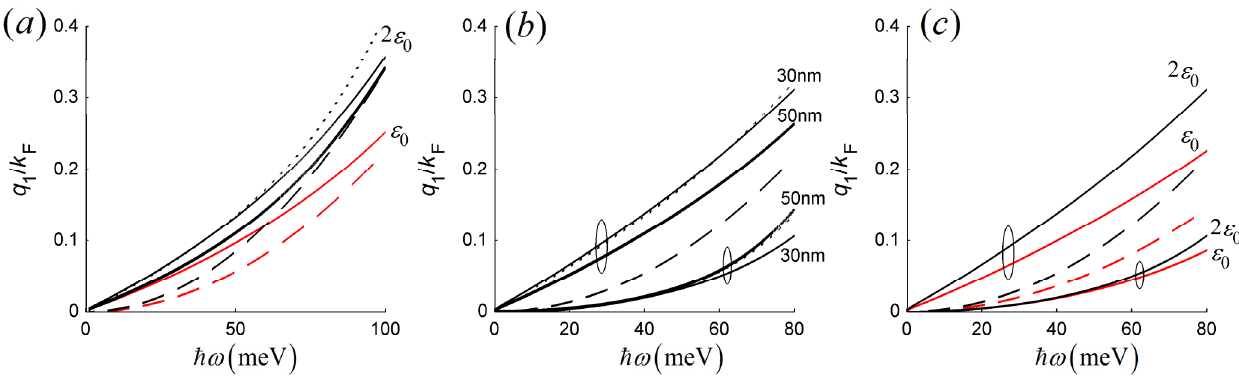
Figure 5. Plasmon dispersion of ( a ) graphene on a gold substrate and ( b , c ) double-layer graphene. The related structures are shown in Figure 3c,d. In all figures, and are used for graphene. Thin solid, thick solid, and dashed curves are calculated for , , and , respectively. Black and red curves are calculated for and , respectively. The dotted curves are obtained using the RPA-RT approach with parameters and . In ( a ), , , , and are used. In ( b , c ), is assumed. Curves for the same plasmon mode are grouped by an